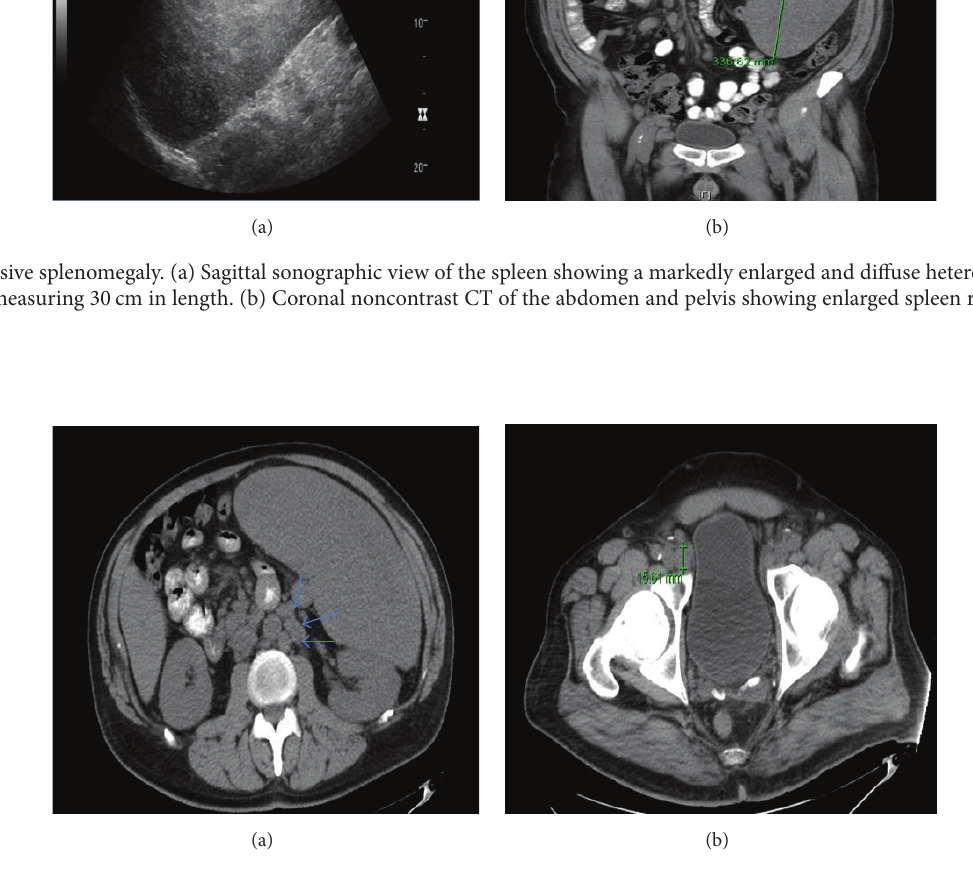
Figure 2: Diffuse lymphadenopathy. (a) Transverse CT of the abdomen showing enlarged para-aortic lymph nodes (blue arrows) reaching 14mm in the shortest axis. (b) Transverse CT of the pelvis showing enlarged inguinal lymph nodes reaching 15mm in the shortest